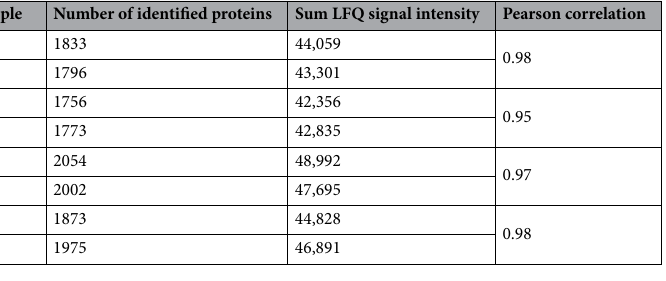
Table 2. Number of identified proteins, sum of the LFQ intensity signal and Pearson correlation value between extraction replicates.